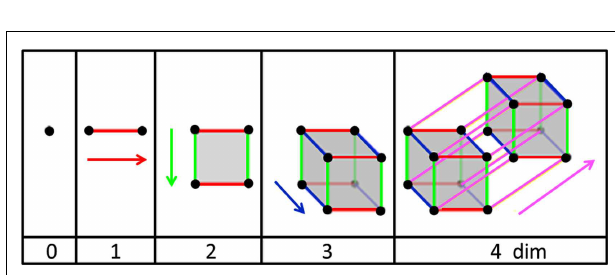
FIGURE 2 | Pathway of a transient trajectory of a dynamical system enroute to its stable singularity. Public source: http://en.wikipedia.org/ wiki/Phase_space